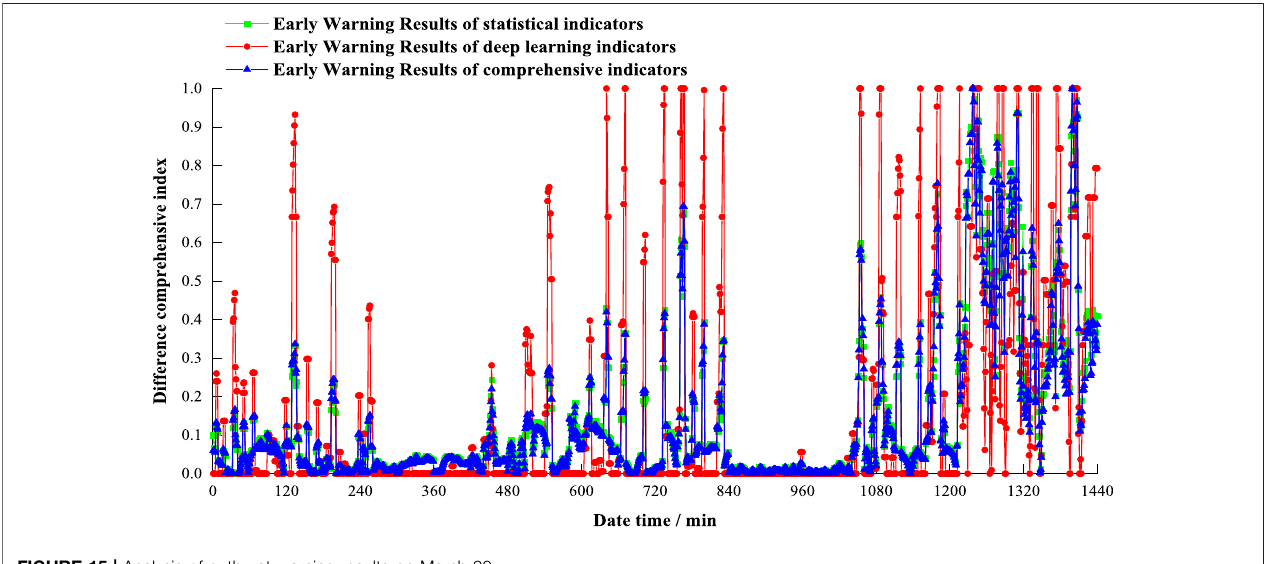
FIGURE 15 | Analysis of outburst warning results on March